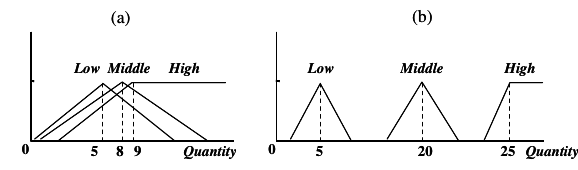
Fig. 4. Two bad membership functions The second objective function is the total number